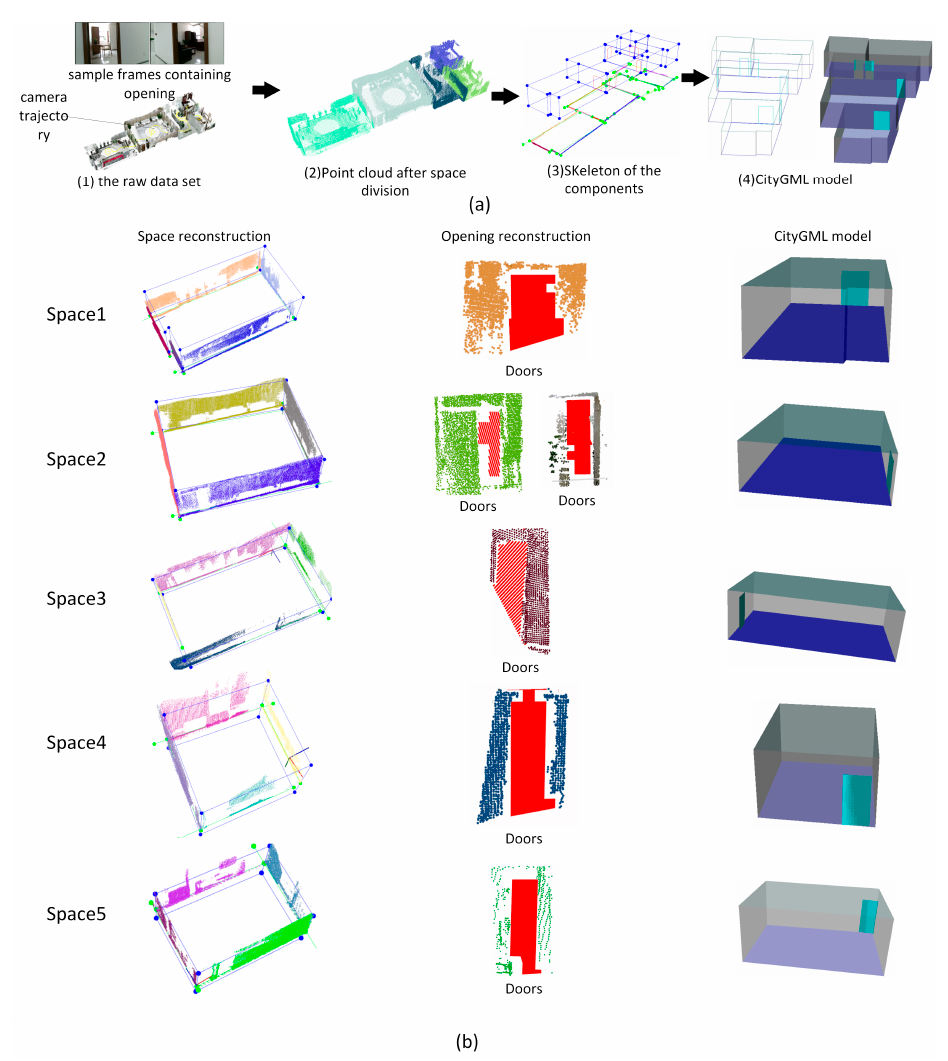
Figure 15. Reconstruction results for case study (4), ( a ) reconstruction results in different stages during indoor reconstruction of the whole model, ( b ) reconstruction results of each functional space in case study (4).